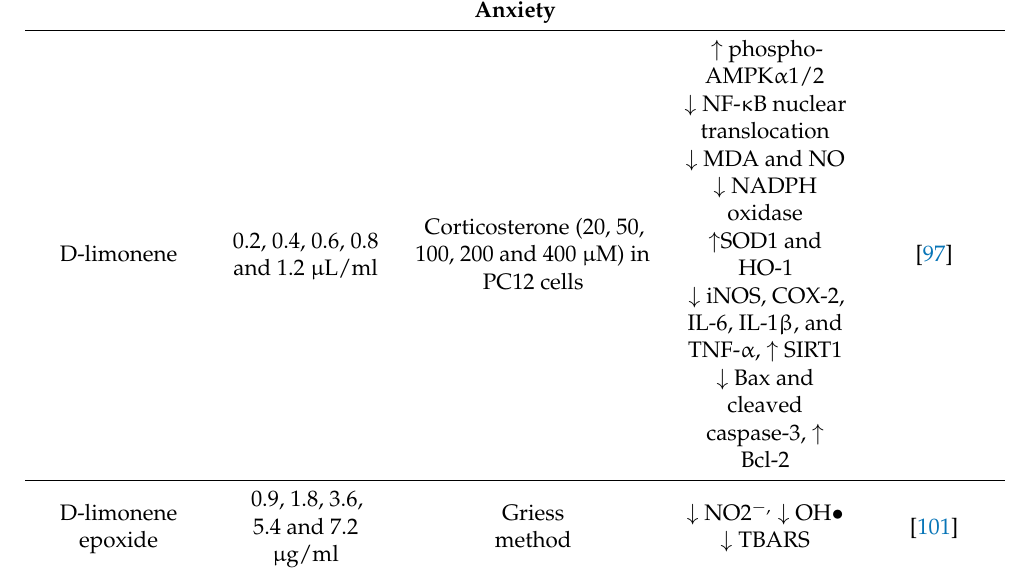
Table 2. The in vitro studies demonstrating the neuroprotective actions and mechanisms of limonene. In